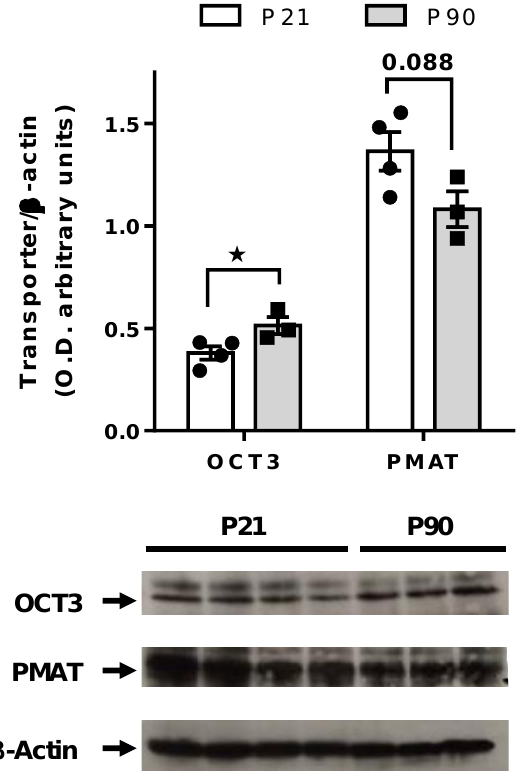
Figure 4. Western blot analyses revealed a trend for greater hippocampal PMAT expression, and lower OCT3 expression, in juvenile mice than in adults. Bands for OCT3, PMAT and β -Actin corresponded to the expected molecular weights of 70, 58 and 40 kDa, respectively. * p < 0.05, unpaired t -tests. Data are mean ± S.E.M. P21 n = 4, P90 n = 3.